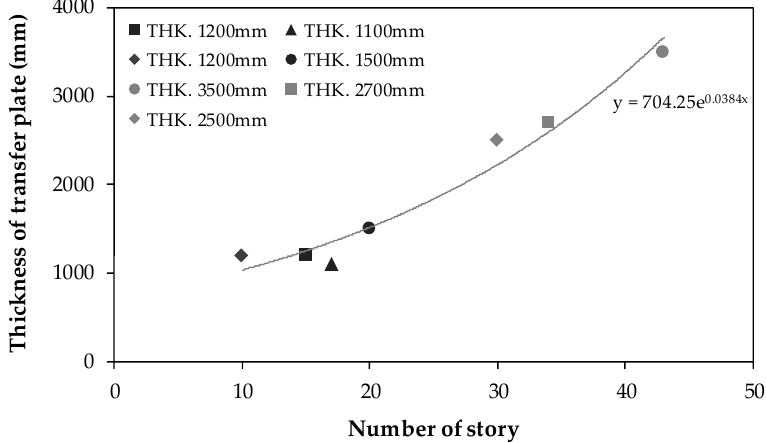
Figure 6. Relationship between thickness of transfer plate and number of upper stories.